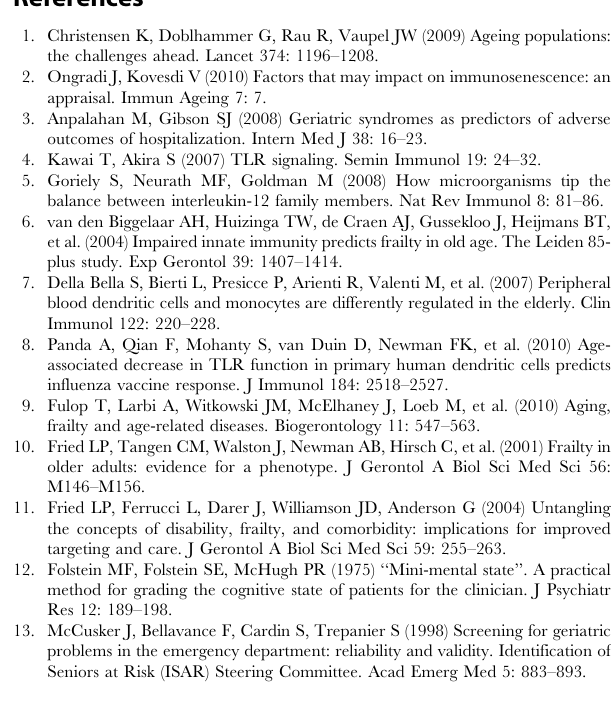
Figure S2 CD80 basal expression on different mono- cytes subsets in non frail and frail old individuals. Whole blood cells were directly fixed after blood collection. Expression of CD80 was assessed for classical monocytes (Lineage – HLA- DR + CD11c + CD14 ++ CD16 2 ), intermediate monocytes (Linea- ge – HLA-DR + CD11c + CD14 + CD16 + ) and inflammatory mono- cytes (Lineage – HLA-DR + CD11c + CD14 dim CD16 + ). MFI (mean) values for each donor are shown. The bars represent median values 6 interquartile range. (TIF) Figure S3 Induction of NF- k B p65, p38 and Erk phosphorylation in monocytes and cDCs after LPS or R848 stimulation. Whole blood cells from healthy old volunteers were incubated with PBS alone or the indicated TLR ligand for 20 minutes. MFI (mean) values for phosphorylated protein in monocytes (Lineage – HLA-DR + CD11c + CD14 + ) or cDCs (Lineage 2 HLA-DR + CD11c + CD14 2 ) are shown. One representative donor of 10 is shown. (TIF) Table S1 Characteristics of subgroup of individuals . 75